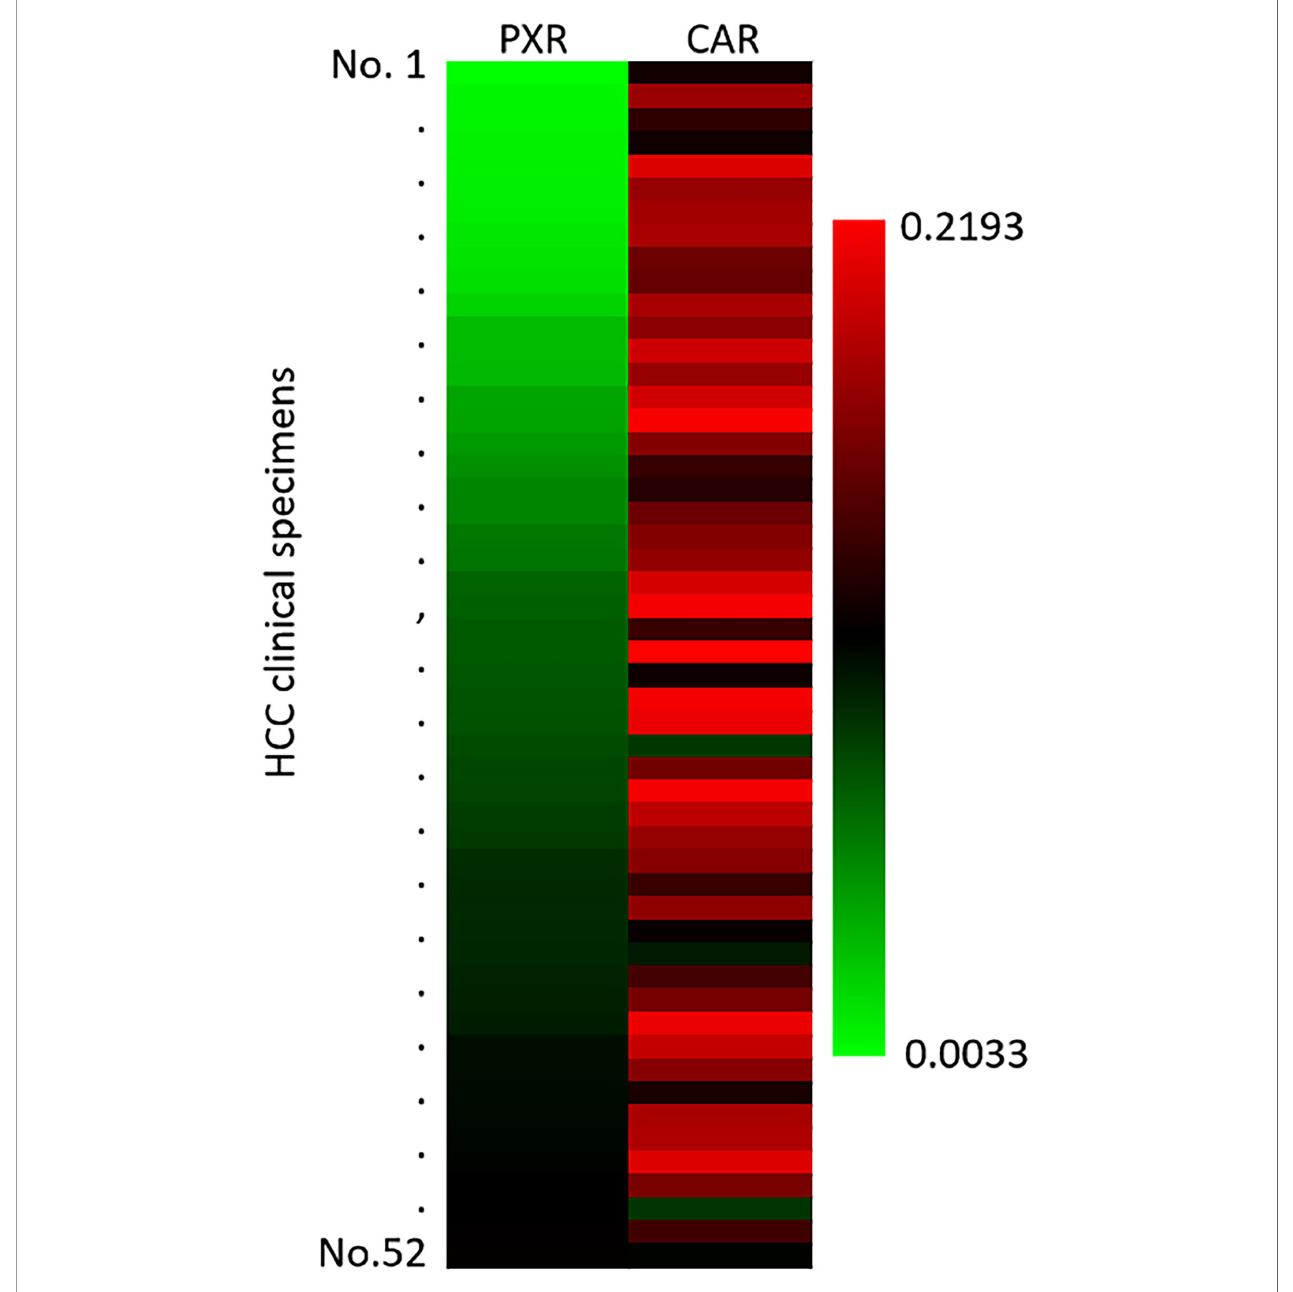
FIGURE 7 | The endogenous expression of PXR or CAR in HCC clinical specimens. The endogenous expression of PXR or CAR in HCC clinical specimens was examined by qPCR. The results were shown as heat-map from the relative expression level (folds of b